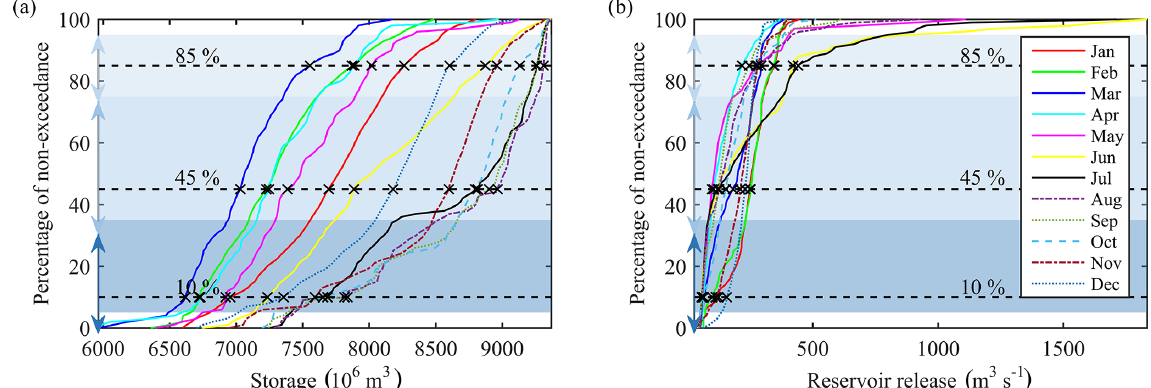
Figure 2. Cumulative distribution function (CDF). (a) Storage CDF of Gardiner Dam. (b) Reservoir-release CDF of Gardiner Dam. Double arrows on y axis show parameterizations ranges for each generalized